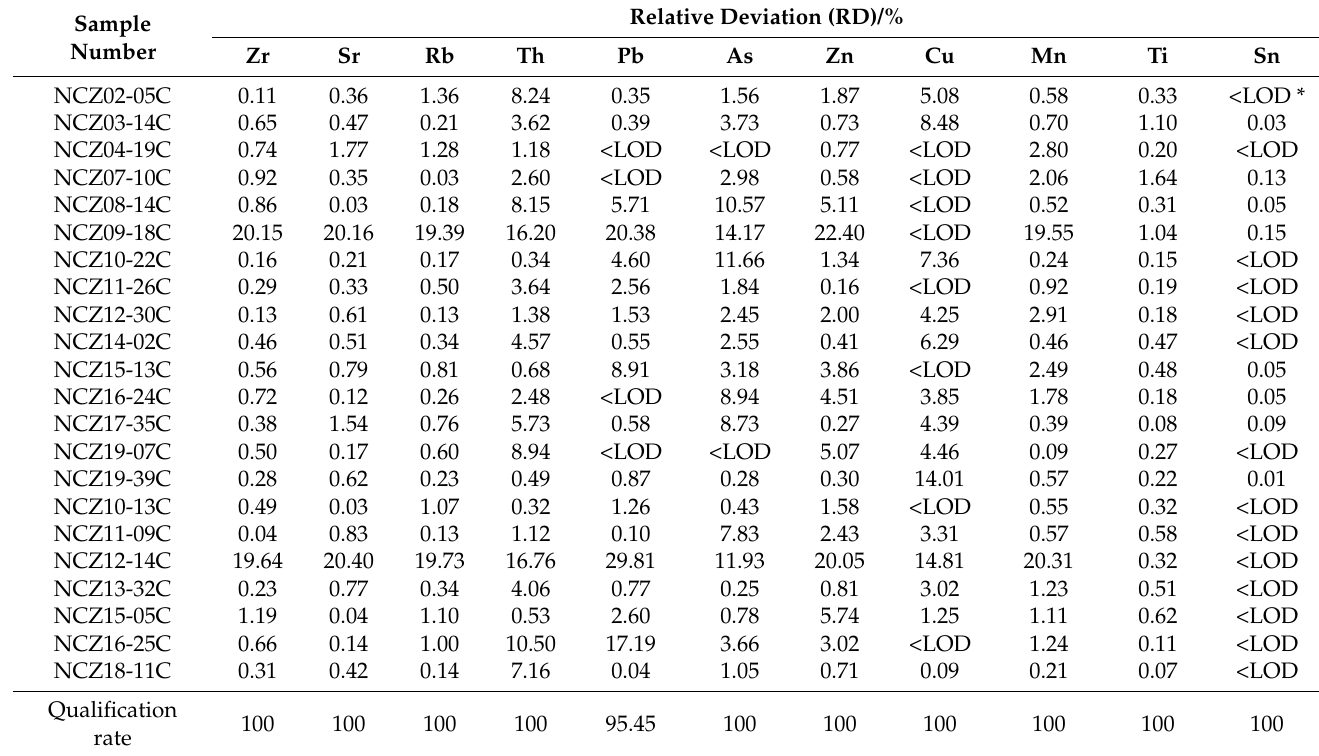
Table 2. Qualification rate of duplicate